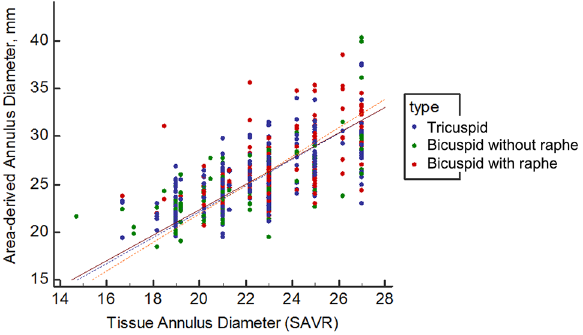
Figure 2. Scatter plot to demonstrate the distribution of area-derived annular diameter measured on CT and tissue annular diameter of surgical aortic valve replacement (SAVR).